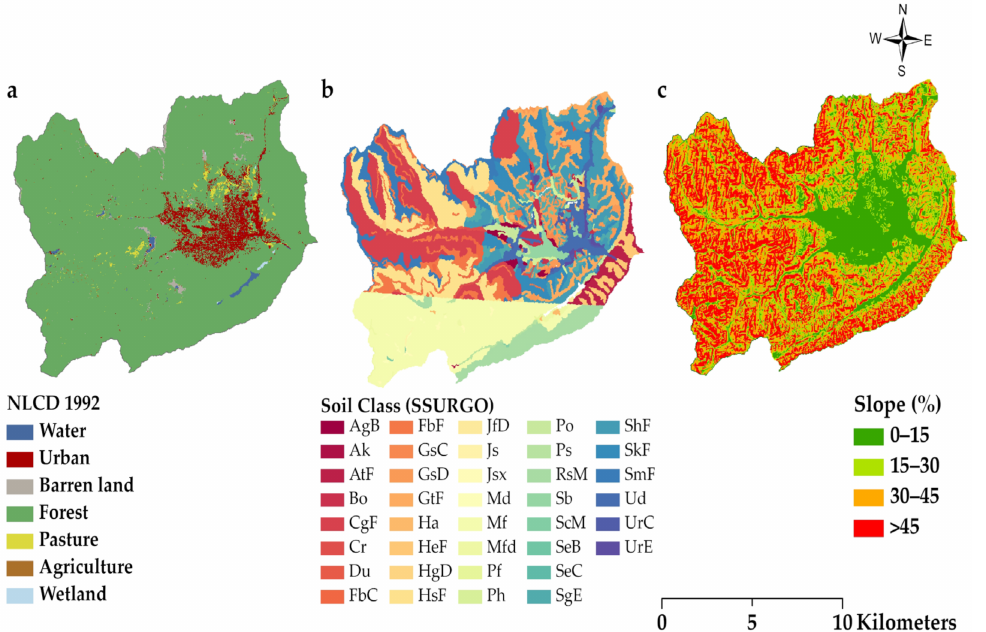
Figure 2. Input data for the SWAT model ( a ) LULC map (1992, NLCD), ( b ) Soil map (SSURGO), and ( c ) Slope map of the Yellow Creek Watershed. (See Table A1 for a complete description of SSURGO soil